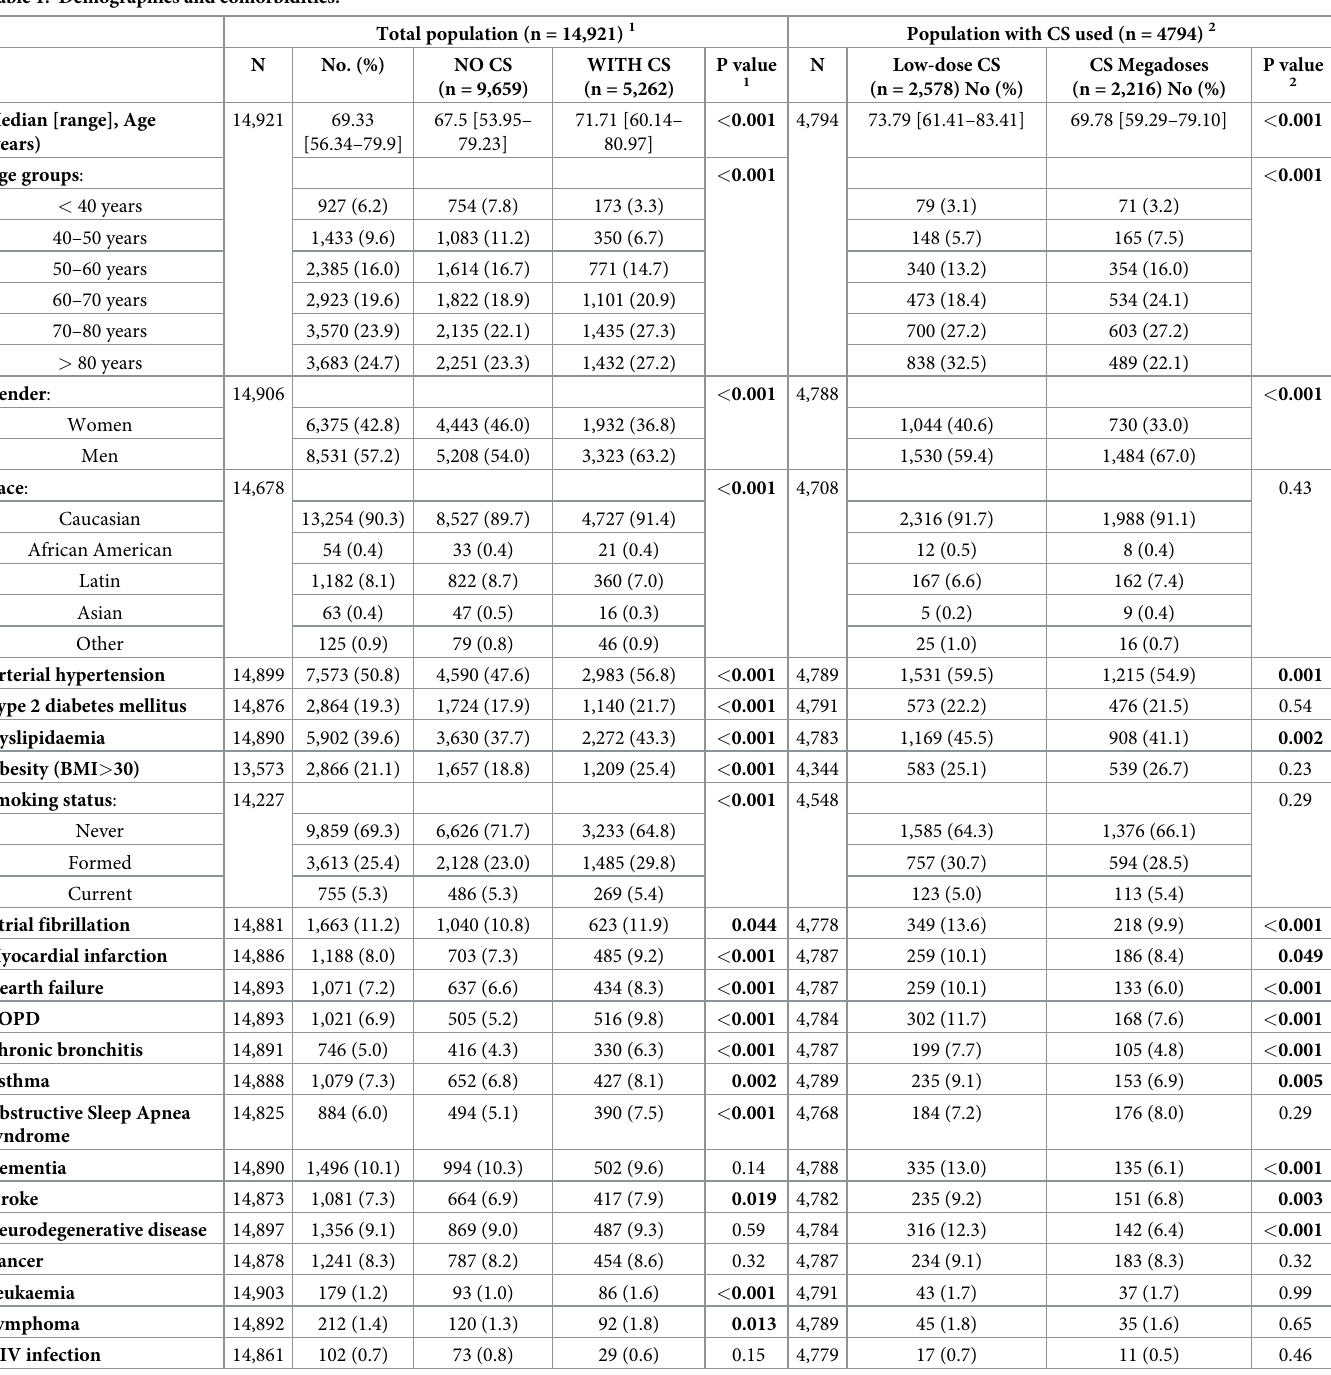
Table 1. Demographics and